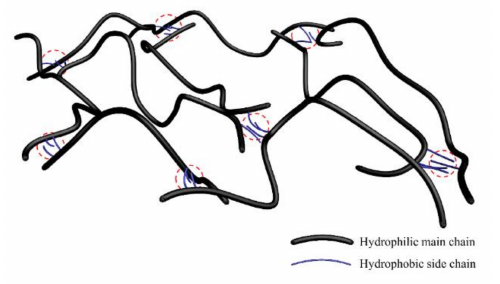
Figure 1. Three-dimensional schematic diagram of interactions of hydrophobically associating